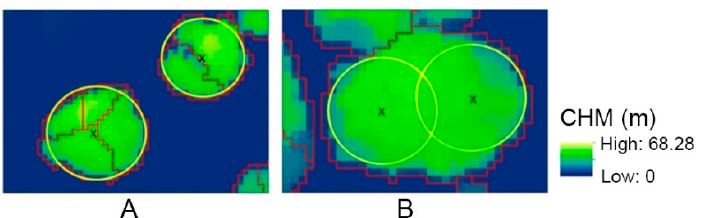
Figure 5. ( A ) Errors of commission: tree crowns are segmented into multiple segments; ( B ) errors of omission: multiple tree crowns are delineated by a single segment. X represents a tree trunk (confirmed in the field, i.e., ground ‐ truthed).